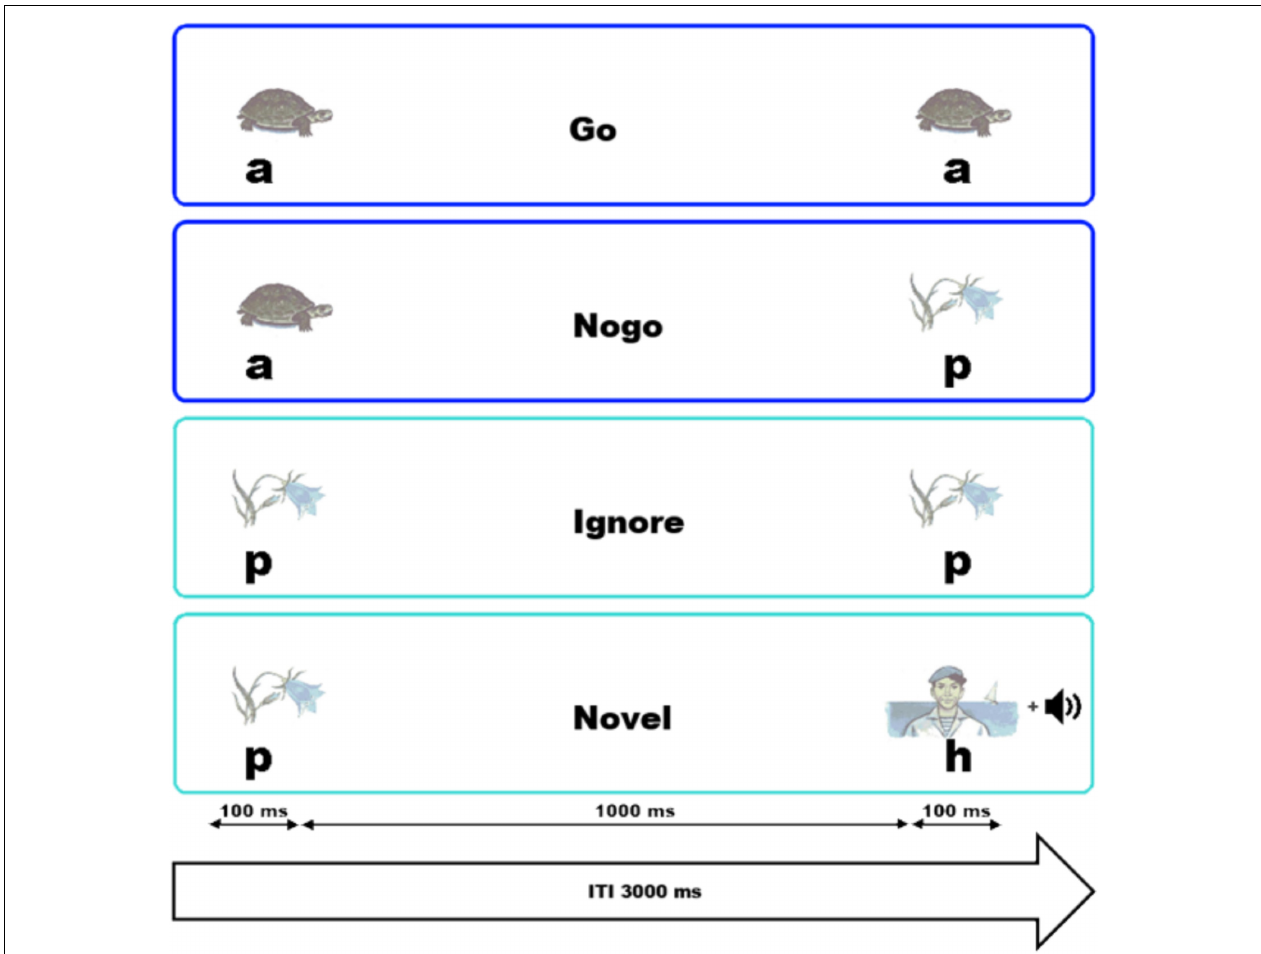
FIGURE 1 | Graphical representation of the tasks and their time dynamics. The instruction in the Go trials was to press a button with the right index finger if two animal (a) pictures were presented in succession. The participant was asked to withhold the reaction in a NoGo trial, when an animal and a plant (p) picture were shown sequentially. For the Ignore trials, two plant pictures were presented in succession and no action was required. In the Novel trials (i.e., no action was required from the participant), a plant followed by a picture of a human (h) and a novel sound were